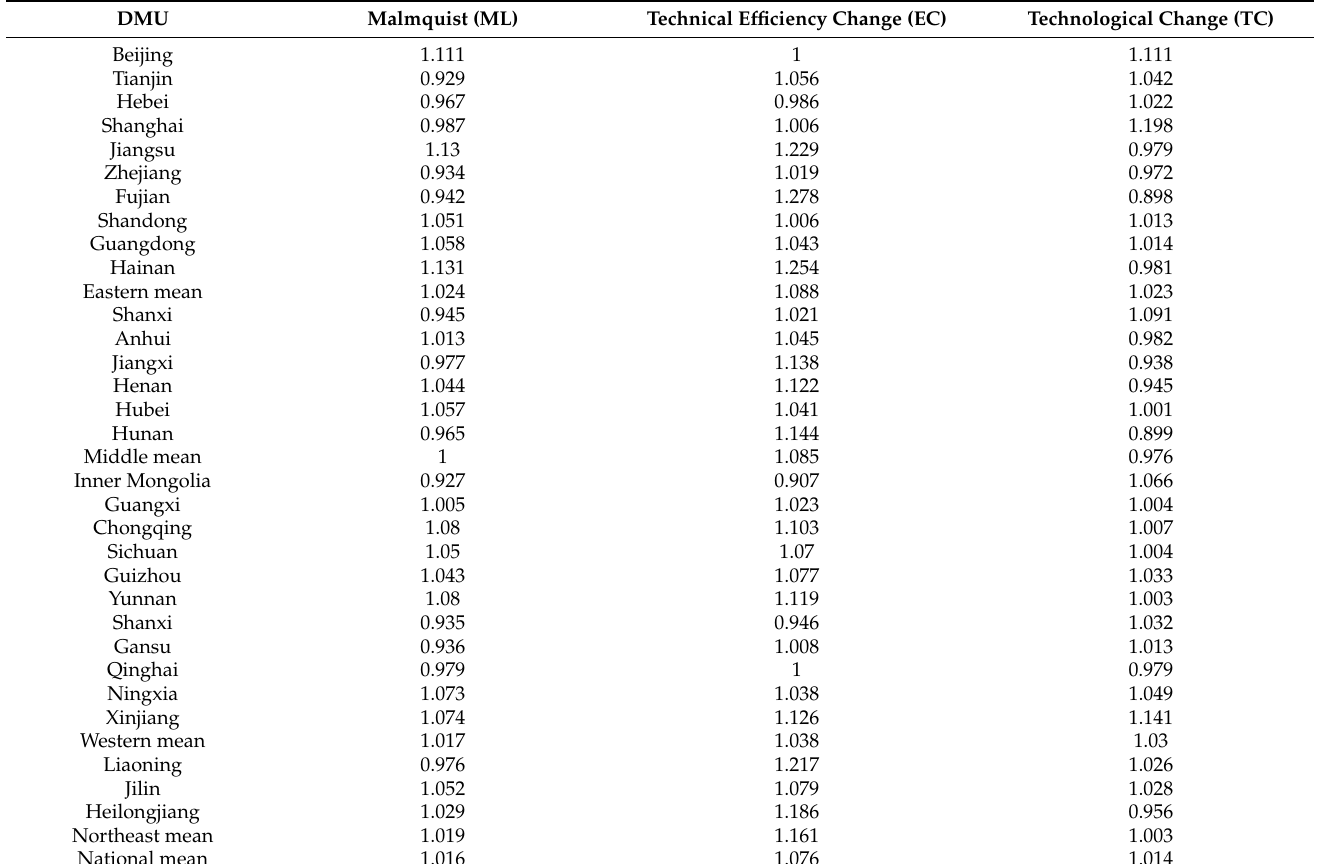
Table 5. Dynamics of environmental efficiency of construction waste generation.